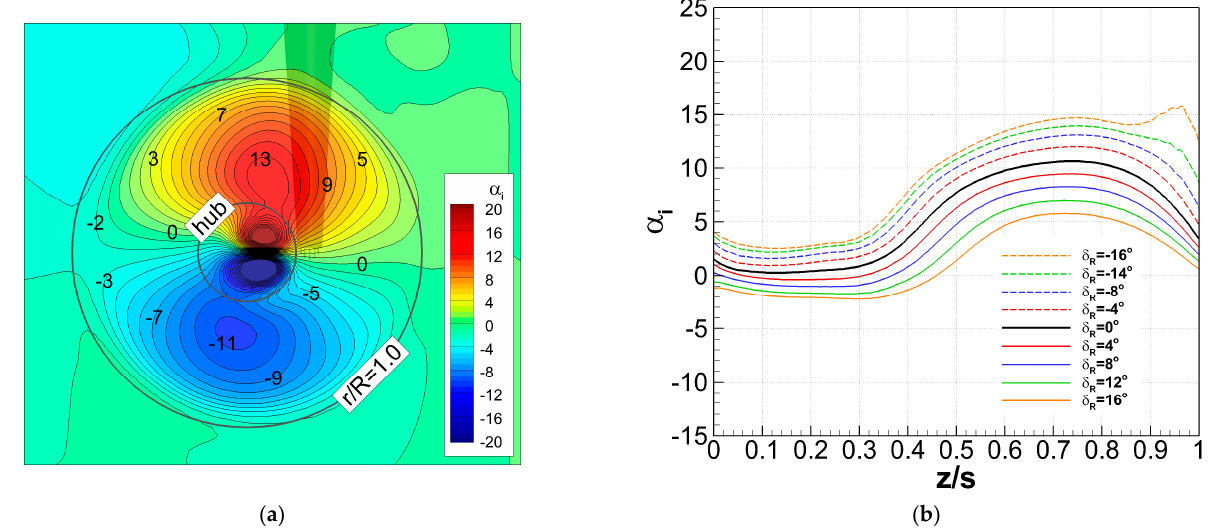
Figure 10. Numerically predicted inflow angle distribution on a transverse plane in front of the port flat rudder and comparison of inflow angles predicted and measured according to rudder angle: ( a ) inflow angle distribution on the measurement plane shown in Figure 9; ( b ) inflow angles in the span direction according to rudder angle.